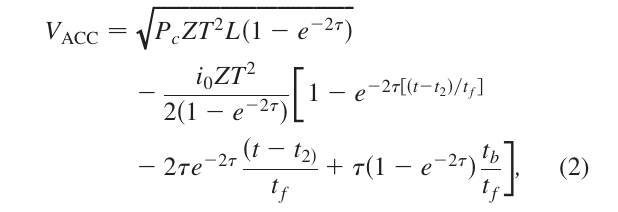
FIG. 10. Energy spread as a function of the injection phase for the old and new